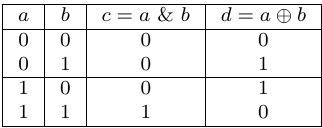
Table 1: Examples of linear and non-linear